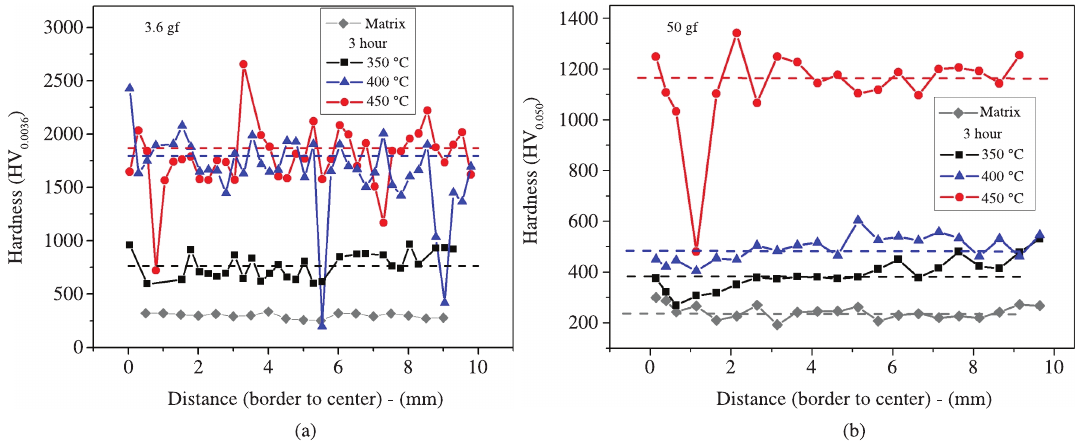
Figure 2. Hardness measurements on surface samples nitrided for 3h, from the border to the center, at different temperatures, using different loads (a) 3.6 gf, (b) 50